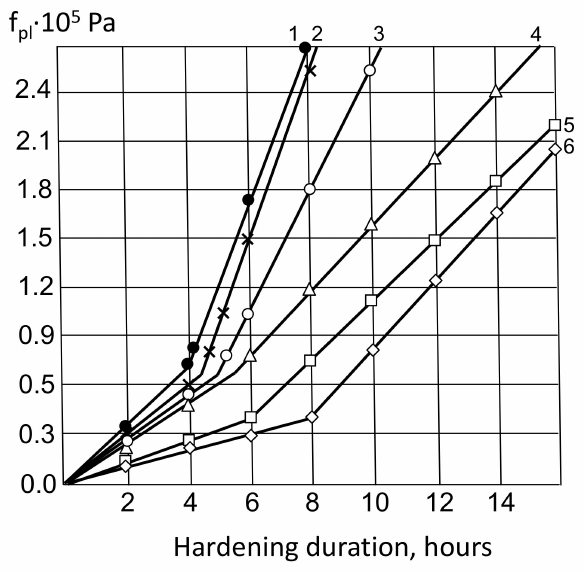
Figure 6. Kinetics of cement-water pastes plastic strength change (f pl ): 1—X 1 = 1; X 2 = 0.2; X 4 = 0; 2—X 1 = 0.5; X 2 = 0.2; X 4 = 0; 3—X 1 = 0.2; X 2 = 0.5; X 4 = 0; 4—X 1 = 1; X 2 = 0.2; X 4 = 0; 5—X 1 = 0; X 2 = 0; X 4 = 0; 6—X 1 = 0; X 2 = 0.5; X 4 =